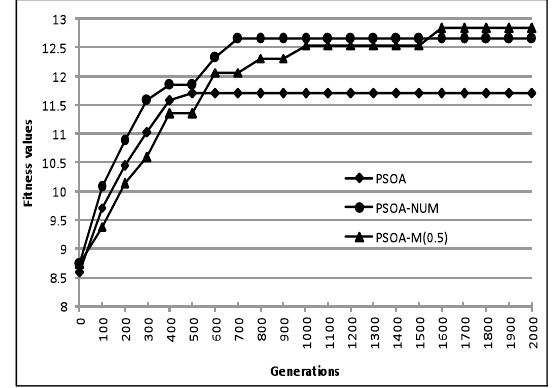
Fig.6 Fitness comparisons for NUM